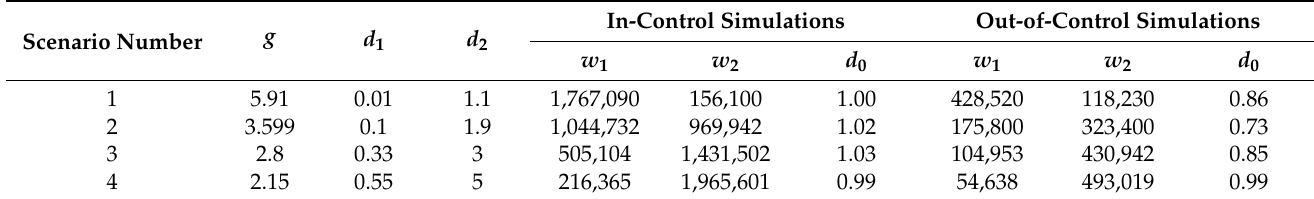
Table 1. The adjustments of VSIGLR chart based on the ATS 0 = 200 and h =